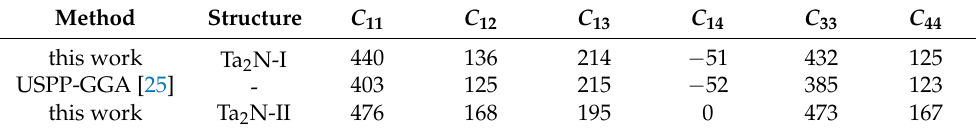
Table 3. The calculated independent elastic constants C ij (GPa) of Ta 2 N-I and Ta 2 N-II.